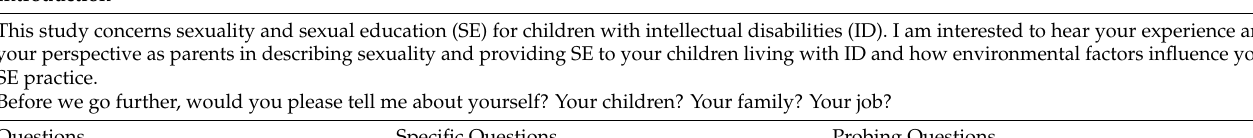
Table 1. Semi-structured questionnaire: an interview